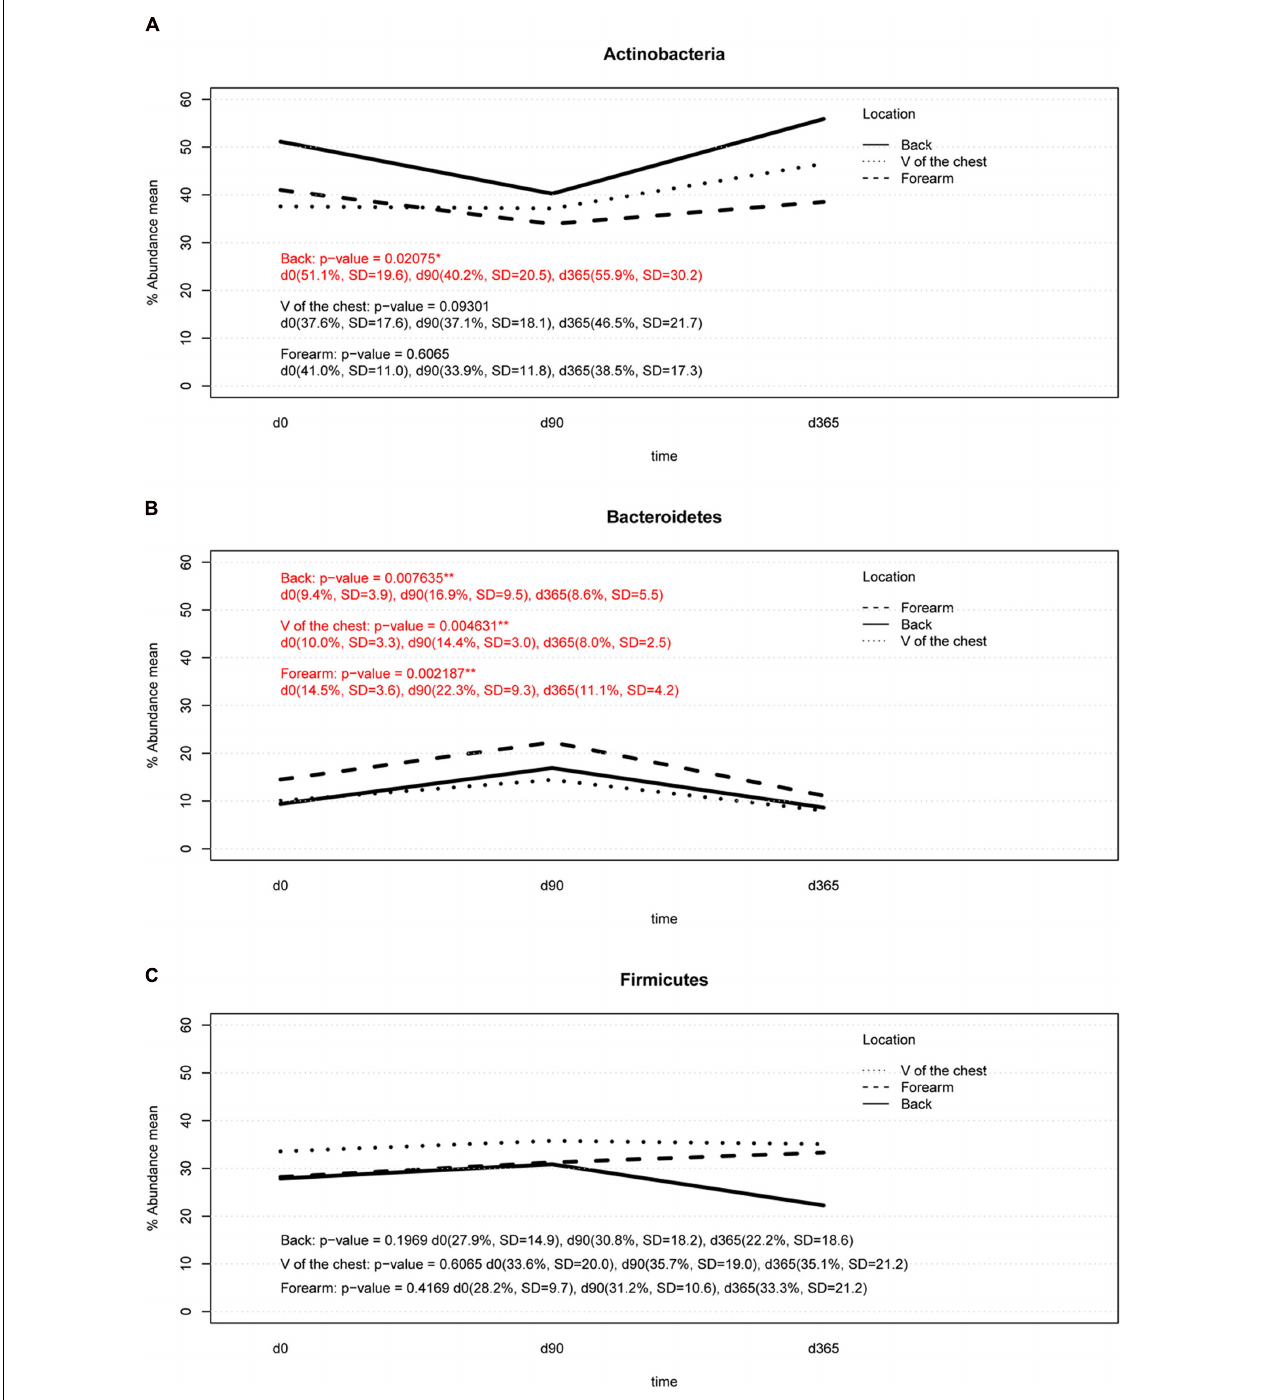
FIGURE 5 | Two-way interaction plot of the relative abundance for the three most abundant phyla, Actinobacteria (A) , Bacteroidetes (B) , and Firmicutes (C) : Actinobacteria showed a significant change in back samples ( p -value lower than 0.05) between d90 vs. d365 ( p -value d0 vs. d90 = 0.0820, p -value d90 vs. d365 = 0.0468, p -value d0 vs. d365 = 0.5468). The relative abundance of Bacteroides increased at d90 in all body locations and returned to baseline at d365 of storage except in forearm samples (d0 vs. d90: p -value forearm = 0.0156, p -value V of the chest = 0.0351, p -value back = 0.0351; d90 vs. d365: p -value forearm = 0.0156, p -value V of the chest = 0.0234, p -value back = 0.0234, d0 vs. d365: p -value forearm = 0.0156, p -value V of the chest = 0.2500, p -value back = 0.4609). No significant changes were detected in Firmicutes in any body location.